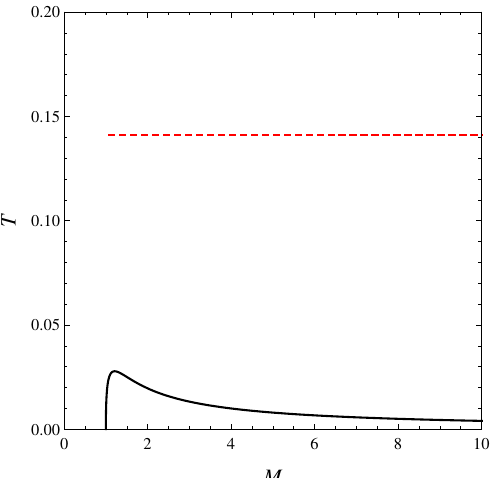
Figure 3. Plots of temperature T as a function of the mass–energy parameter M at fixed J — standard (black solid) and formal logarithm (red dashed) approaches. The standard temperature has a local maximum. The smaller mass branch corresponds with h > h c , and the larger mass with h < h c . The new temperature is a horizontal line because it is an energy-independent